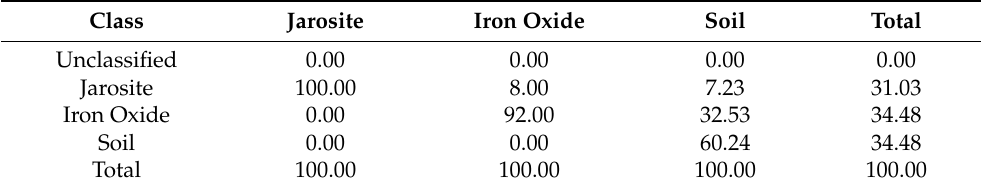
Table A9. June 2018 spectral angle mapper. Overall accuracy points: 110/145, overall accuracy: 75%, kappa coefficient: 0.6365.